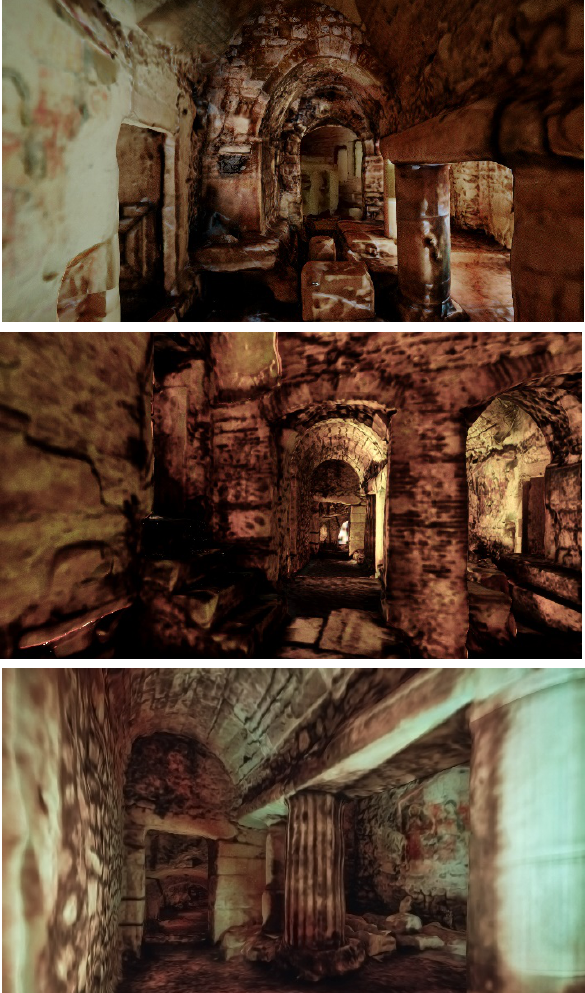
Figure 8. A few frames of the immersive tour inside the digitally reconfigured, textured model of the catacombs, optimized for interactive